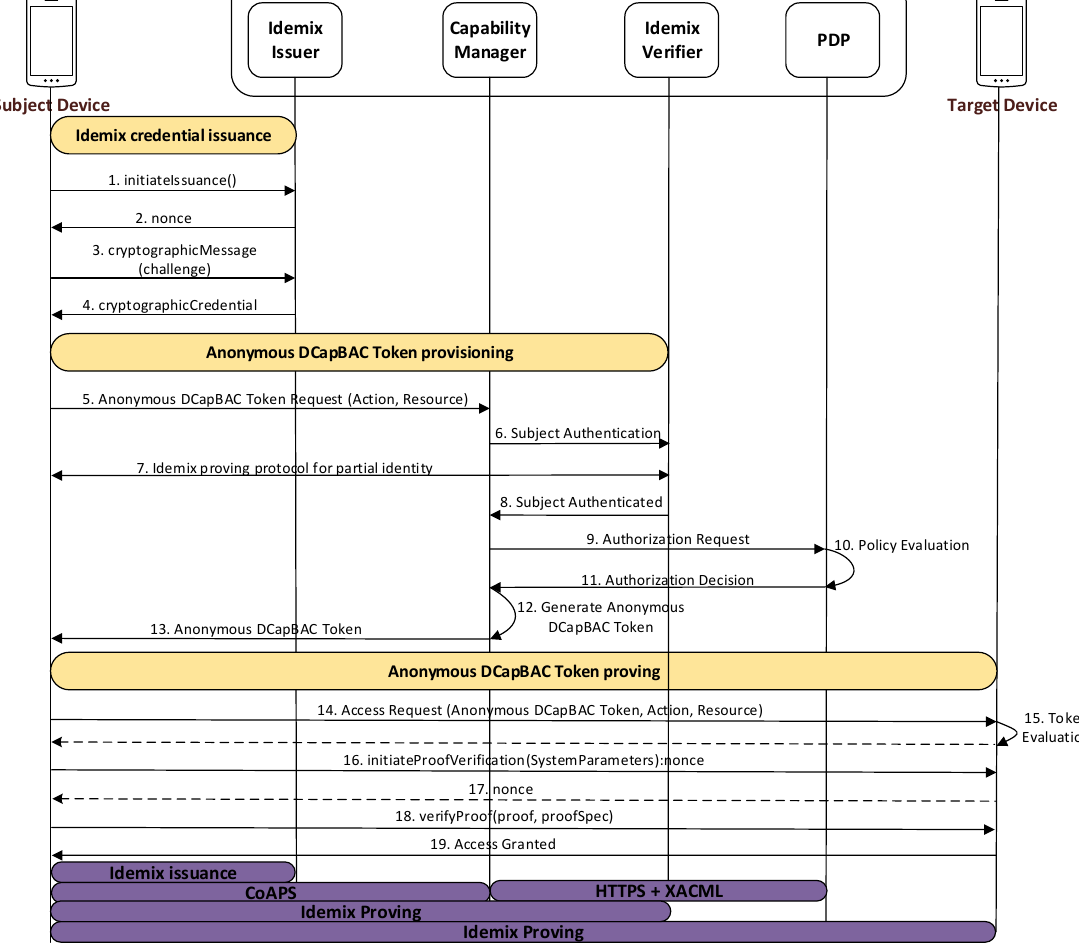
Figure 5. Idemix-based Anonymous DCapBAC